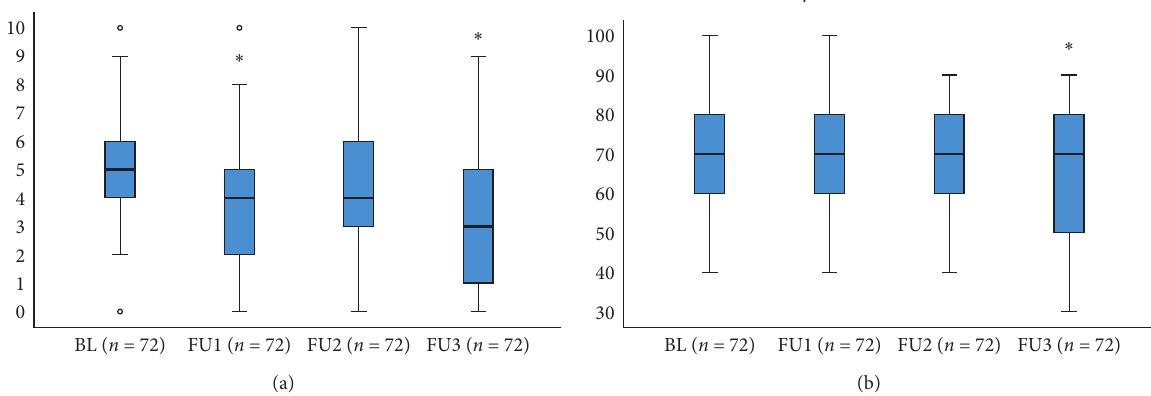
Figure 2: (a) Average pain intensity (7 days recall) at each time point. (b) Karnofsky Performance Status at each time point for patients with complete data. ∗ p value < 0.02 using Wilcoxon signed-rank test when comparing each time point to